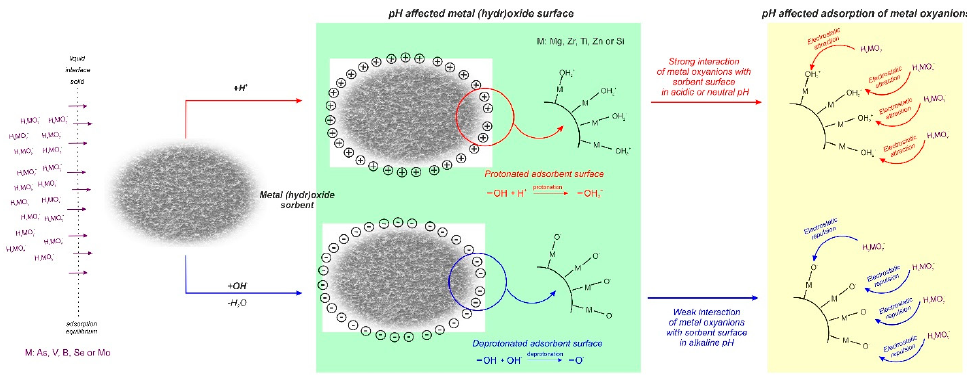
Figure 9. Mechanism of metal oxyanions adsorption onto metal (hydr)oxide-based sorbents.